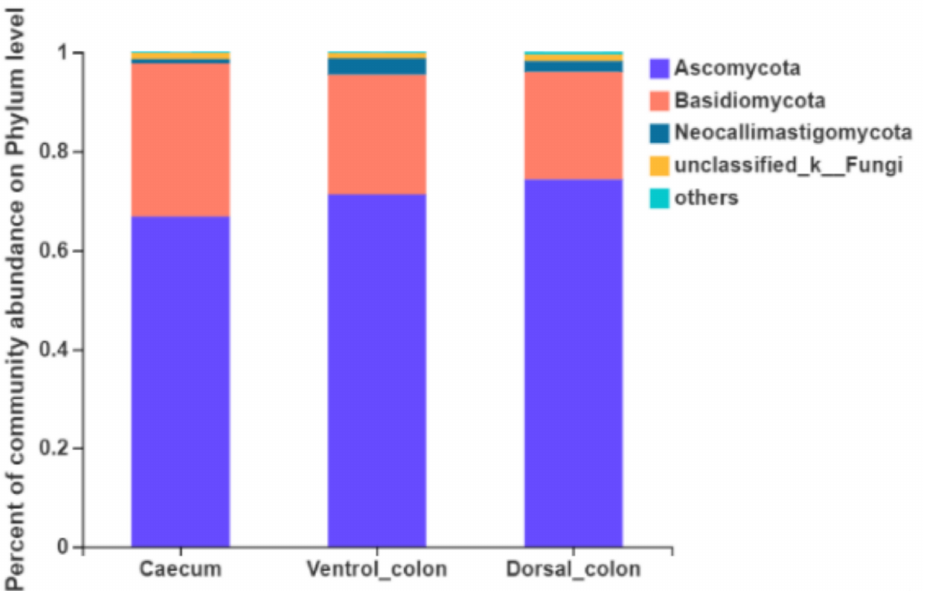
Figure 3. Composition of the predominant fungal phyla (relative abundance ≥ 1%) among donkey caecum, ventral colon, and dorsal colon ( n =